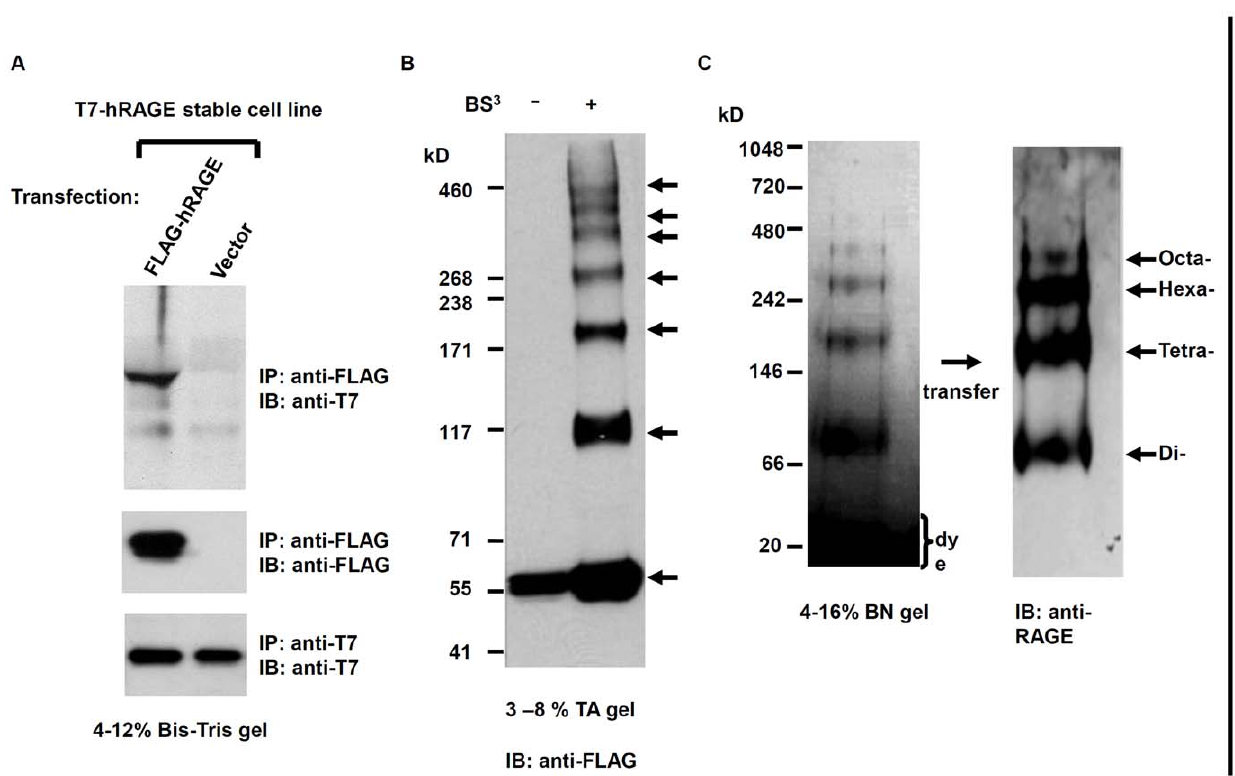
Figure 1. Oligomerization of RAGE. ( A ) Co-immunoprecipitation of differentially tagged RAGE. ( B ) Crosslinking of oligomeric RAGE. FLAG-tagged RAGE cDNA was tranfected to CHO-CD 14 cells and membrane fraction was crosslinked with BS 3 and resolved with SDS-PAGE. Arrows indicate (starting from the bottom) resolved monomers, dimers, trimers, tetramers, pentamers, hexamers, and heptamers. ( C ) Human recombinant soluble RAGE resolved with Invitrogen blue native gel, and blotted with anti-RAGE antibodies. Arrows indicate (starting from the bottom) resolved dimers, tetramers, hexamers, and octamers.